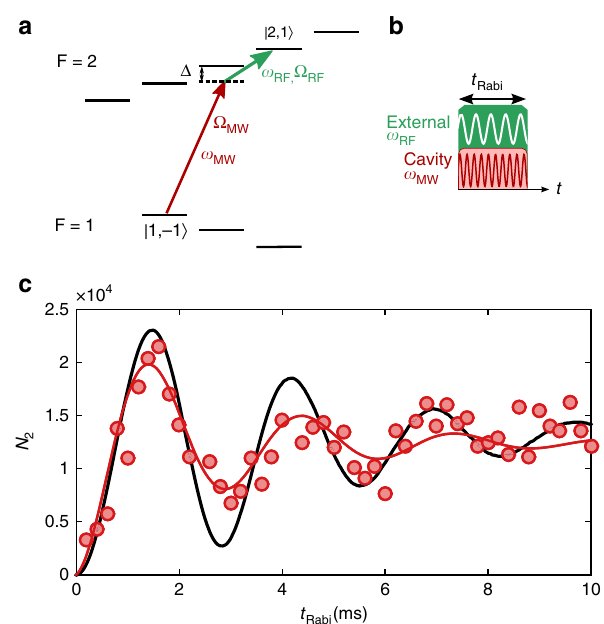
Fig. 4 Two-photon Rabi oscillations. a Level scheme and b timing sequence for the two-photon Rabi oscillations between the trapped states | 1, − 1 〉 and | 2, 1 〉 . c Observation of two-photon Rabi oscillations between states | 1, − 1 〉 and | 2, 1 〉 (circles), and fi t of the damped oscillation (red), yielding a damping time of τ = 5 ms due to the inhomogeneity of the MW fi eld amplitude across the cloud. The black solid line shows a numerical simulation of the state evolution for an ensemble of thermal atoms moving in the